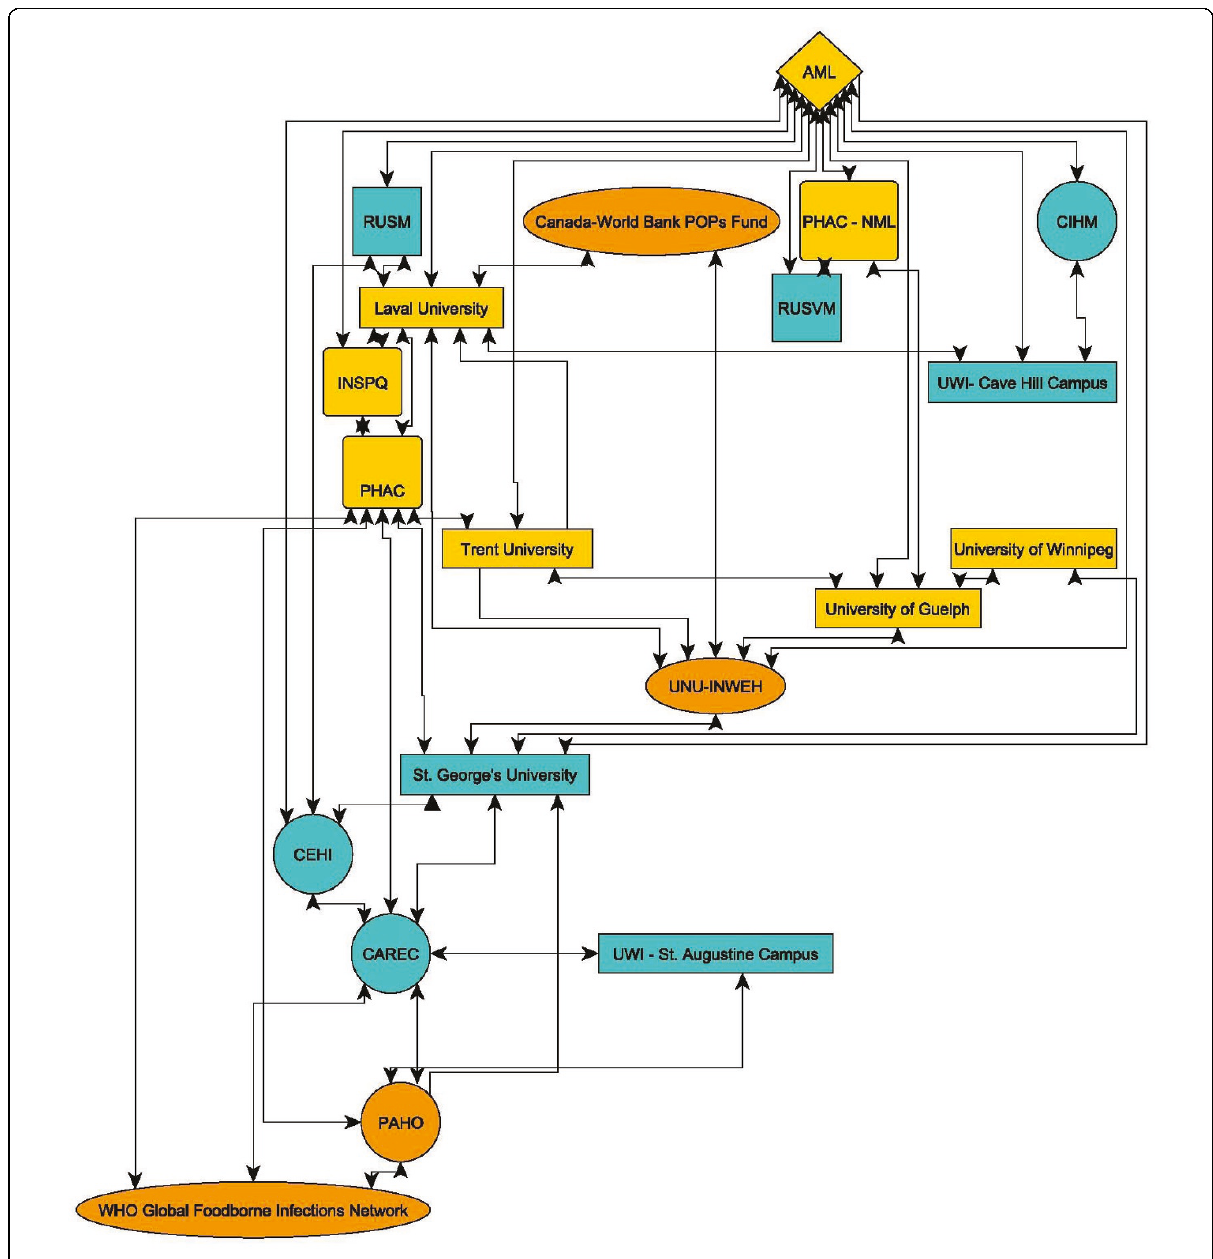
Figure 4 Schematic Drawing of Current CEHP Partners, excluding local groups and national governments, as of